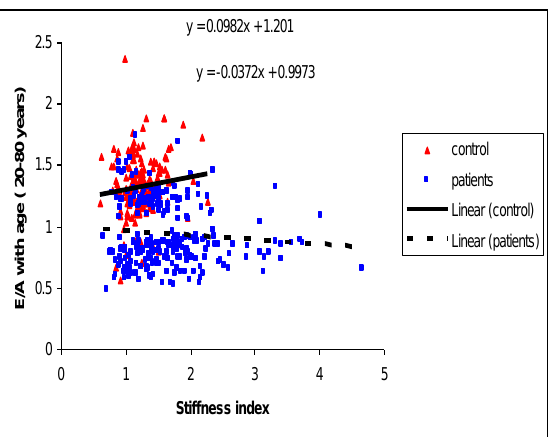
Fig.5: The relation between stiffness index and E/A ratio